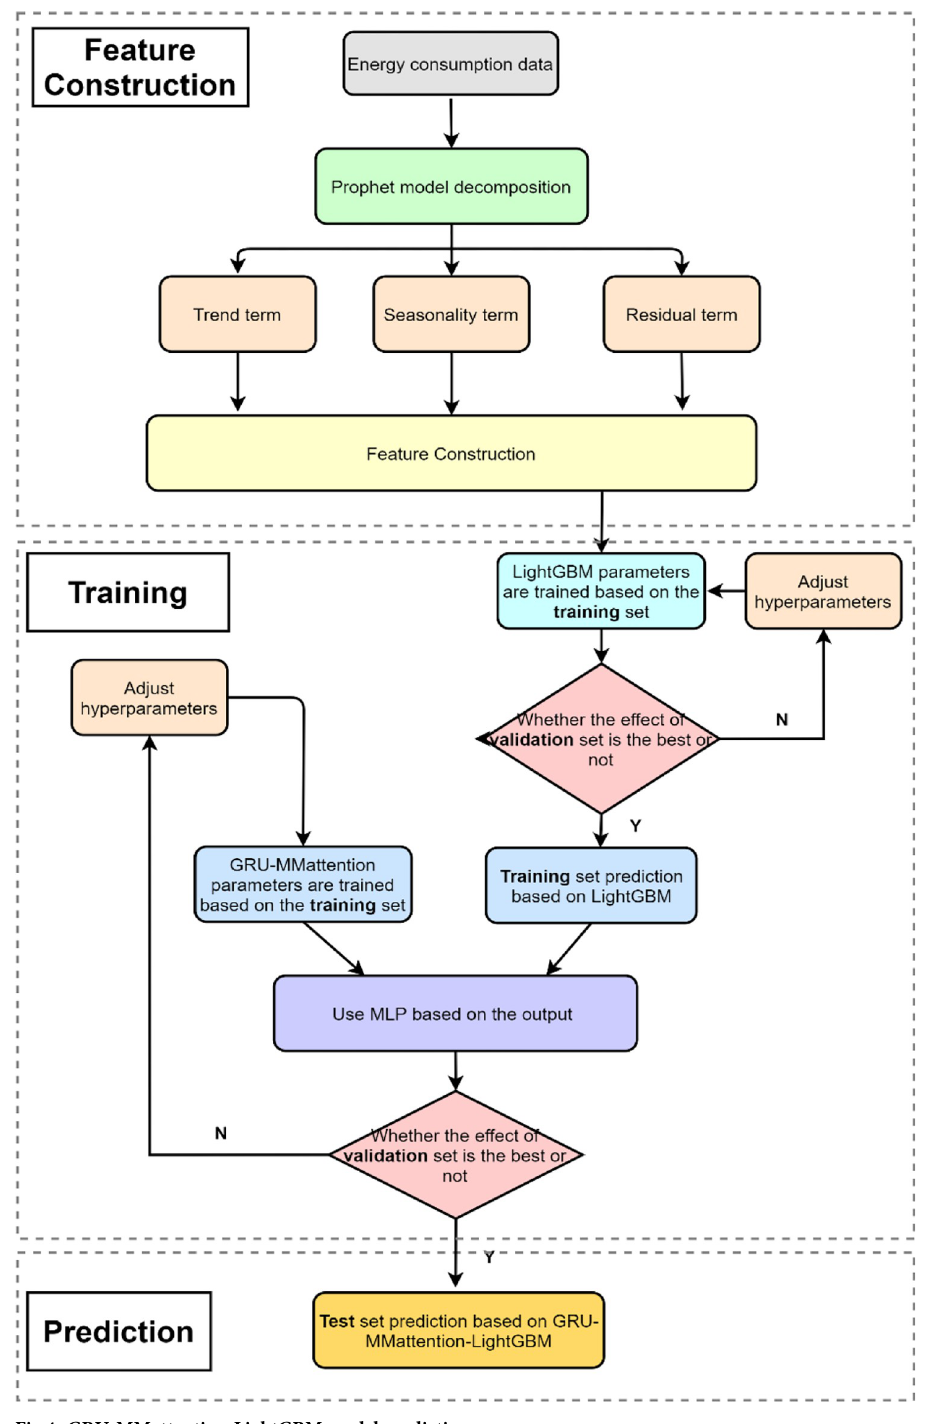
Fig 4. GRU-MMattention-LightGBM model prediction process.